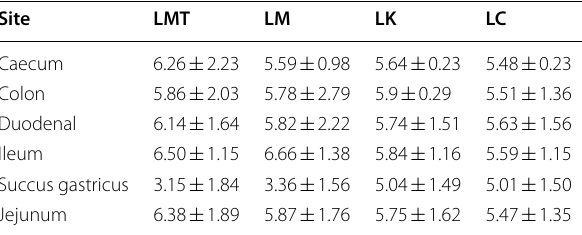
Table 3 pH of the gastrointestinal content of weaned piglets